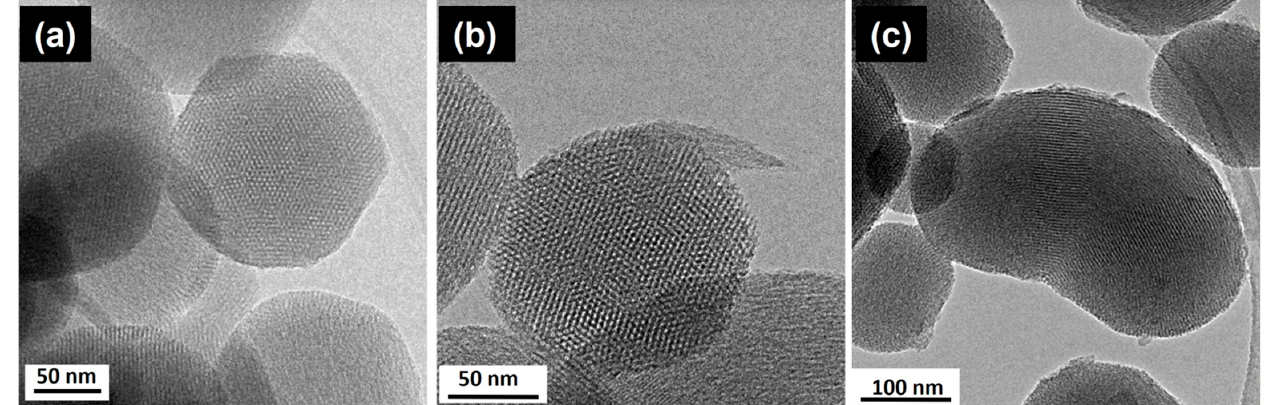
Figure 3. HRTEM images from ( a ) MSN and amine-functionalized MSN with TEOS:APTES mole ratio ( b ) 90:10—MSN-10N and ( c ) 70:30—MSN-30N. Adapted with permission from [43]. Copyright 2018 Elsevier (Amsterdam, The Netherlands).